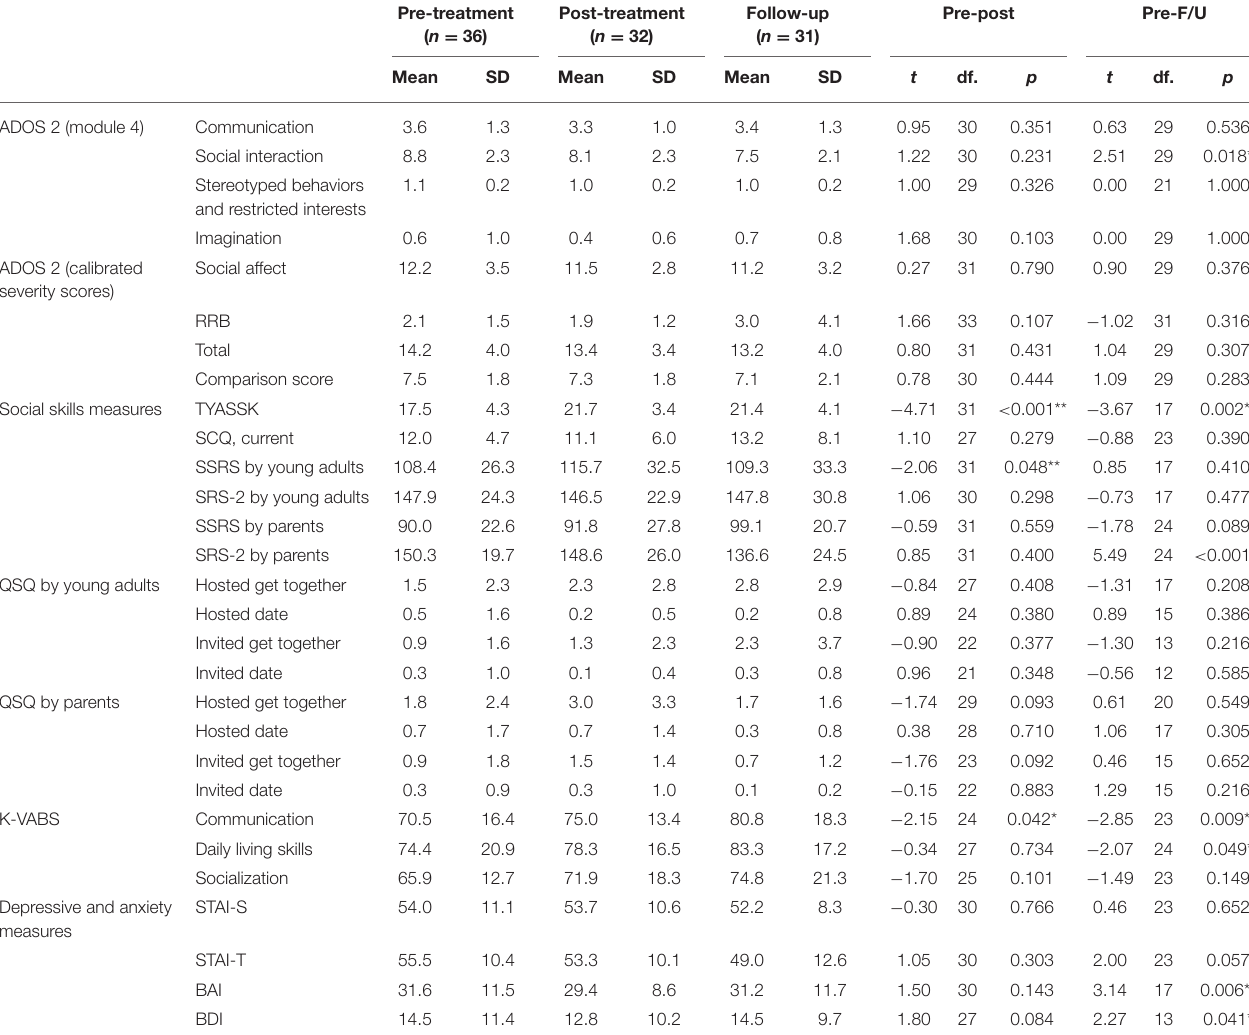
TABLE 3 | Comparison of pre-treatment, post-treatment, and 4 months follow-up outcome measures.